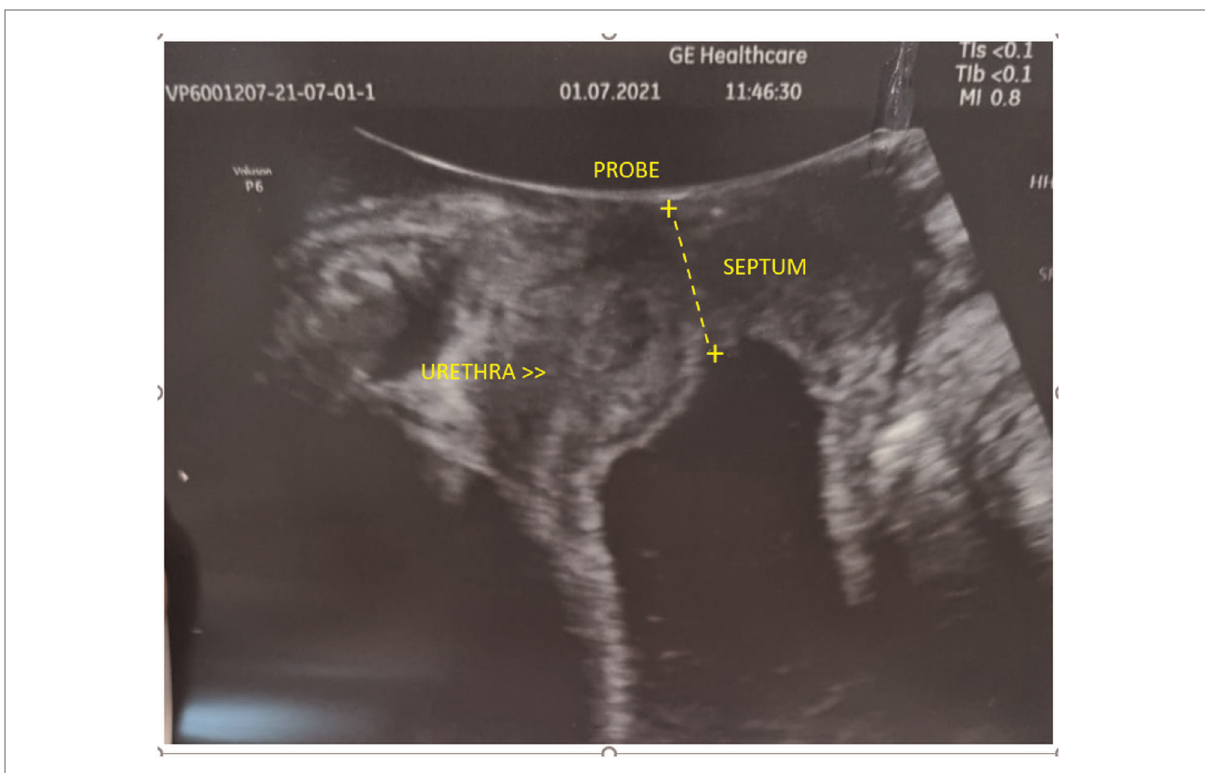
FIGURE 1 Transperineal ultrasound pictures: transverse vaginal septum approximately 1.2 cm in thickness appears as a hyperechoic structure. Below, it is seen as a large hypoechoic mass that responds to the accumulation of fl uids in the